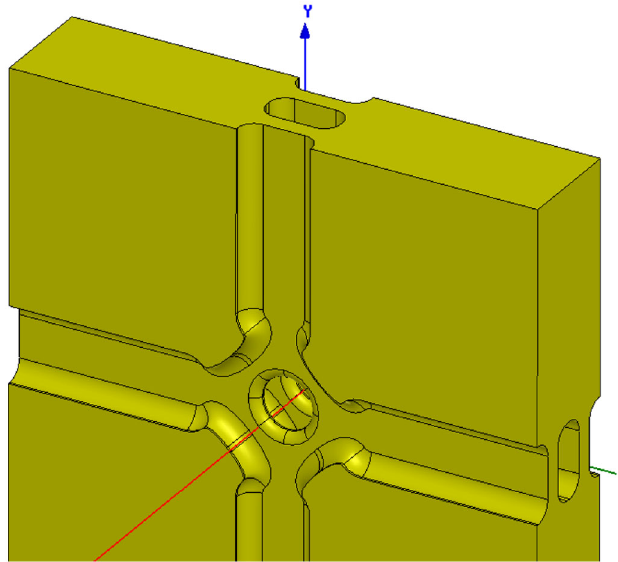
FIG. 2. (Color) CAD drawing of single cell for the main linac structures of CLIC [39,40].